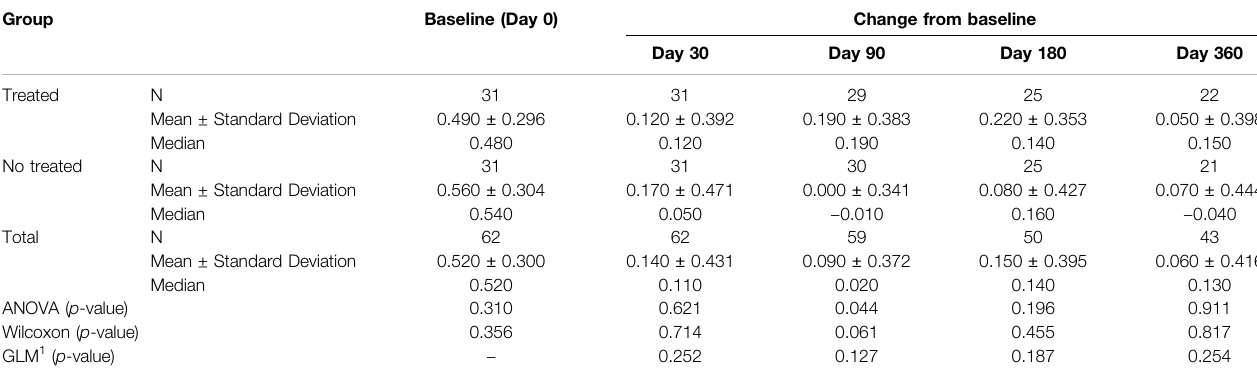
TABLE 4E | (part 5 of 5). GAIT parameters cohort without outliers. Peak Hip Ab-Adduction. General Linear Model with Peak Hip Ab-Adduction change from baseline as dependent variable, treatment as factor, and Peak Hip Ab-Adduction baseline value as covariate.